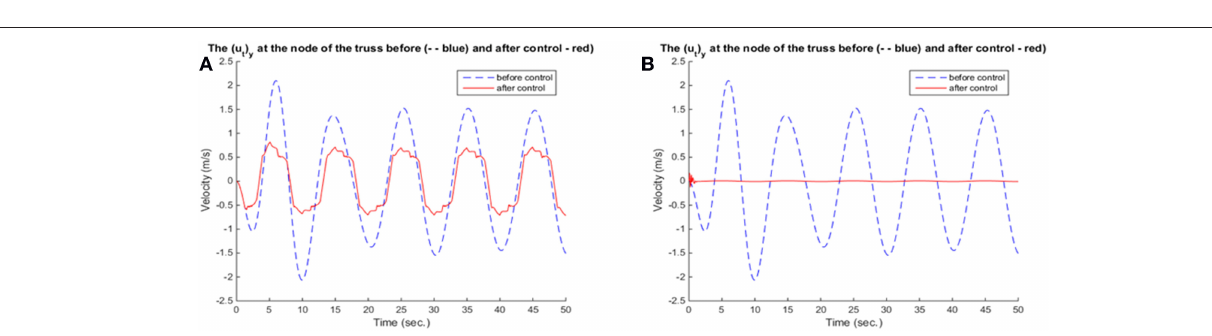
FIGURE 12 | Velocity of node 16 for (A) fuzzy controller and (B) neuro-fuzzy controller.